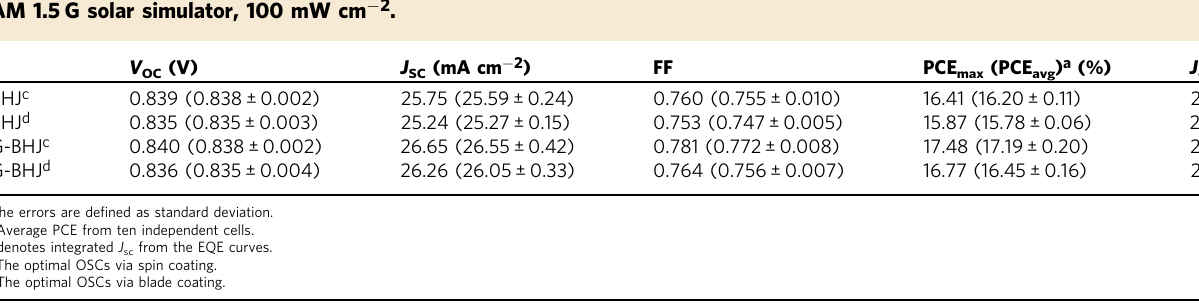
Table 1 Device performances of BHJ and G-BHJ OSCs via spin coating and blade coating processes under the illumination of an AM 1.5 G solar simulator, 100 mW cm − 2